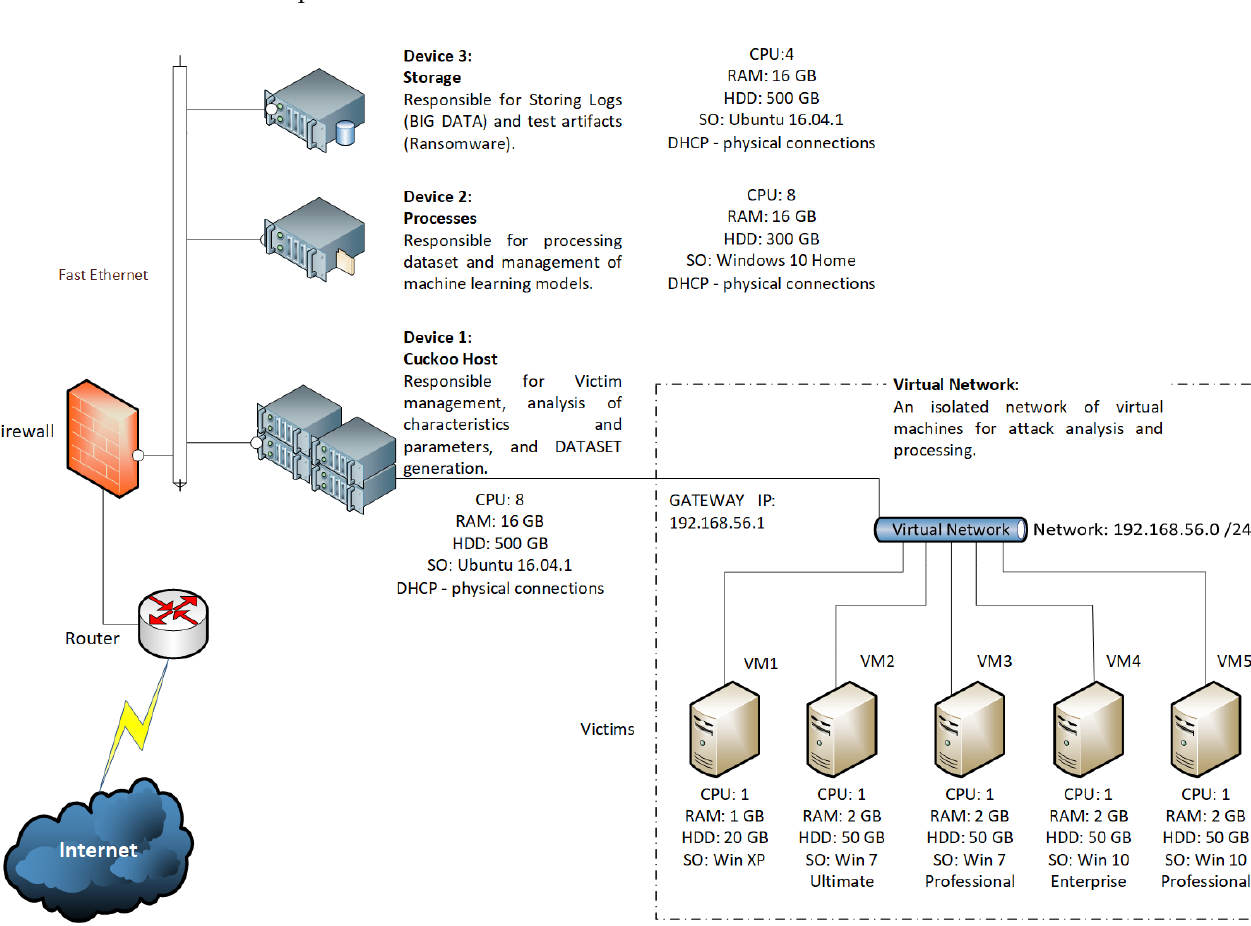
Figure 3. Test environment network topology.